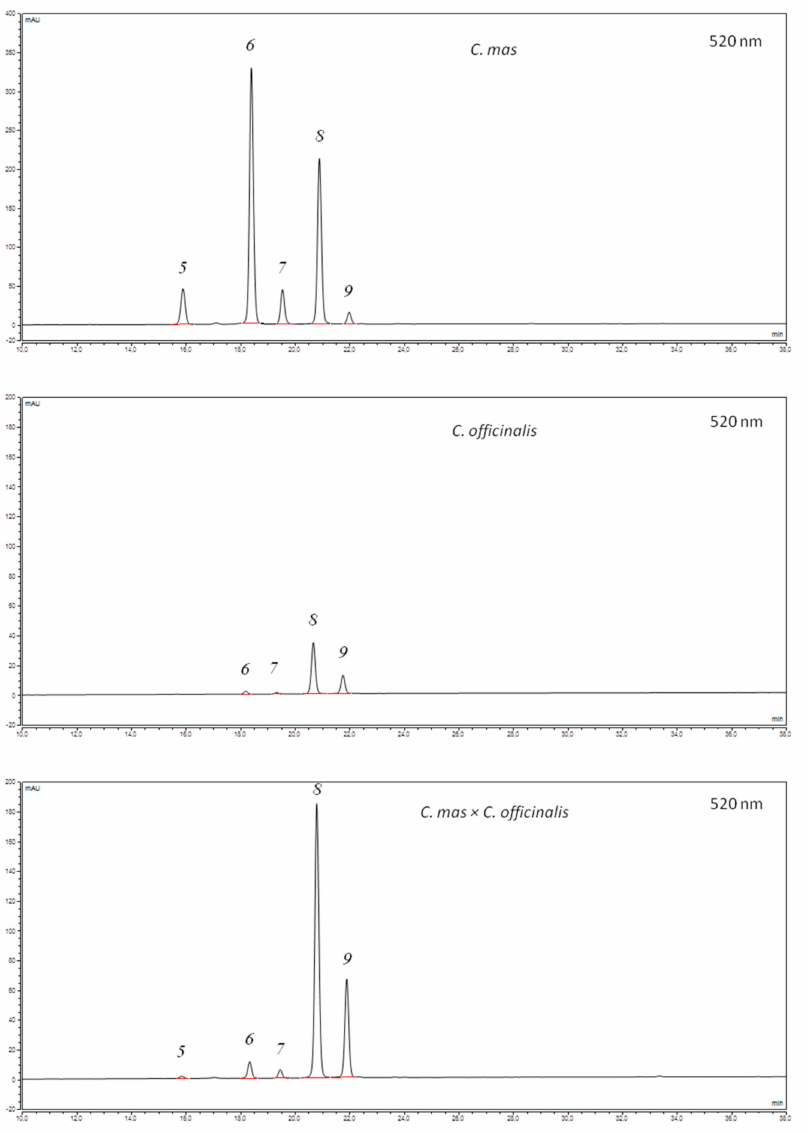
Figure 3. HPLC-PDA chromatograms (520 nm) of anthocyanins of Cornus mas L. (cv. Uholok), C. officinalis Siebold & Zucc., and C. mas × C. officinalis fruit extracts: 5—delphinidin 3-O-galactoside; 6—cyanidin 3-O-galactoside; 7—cyanidin 3-O-robinobioside; 8—pelargonidin 3-O-galactoside; 9— pelargonidin